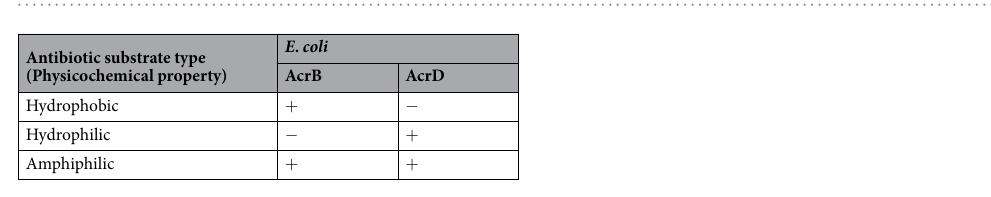
Table 2. General physicochemical properties of antibiotic substrates of AcrB and